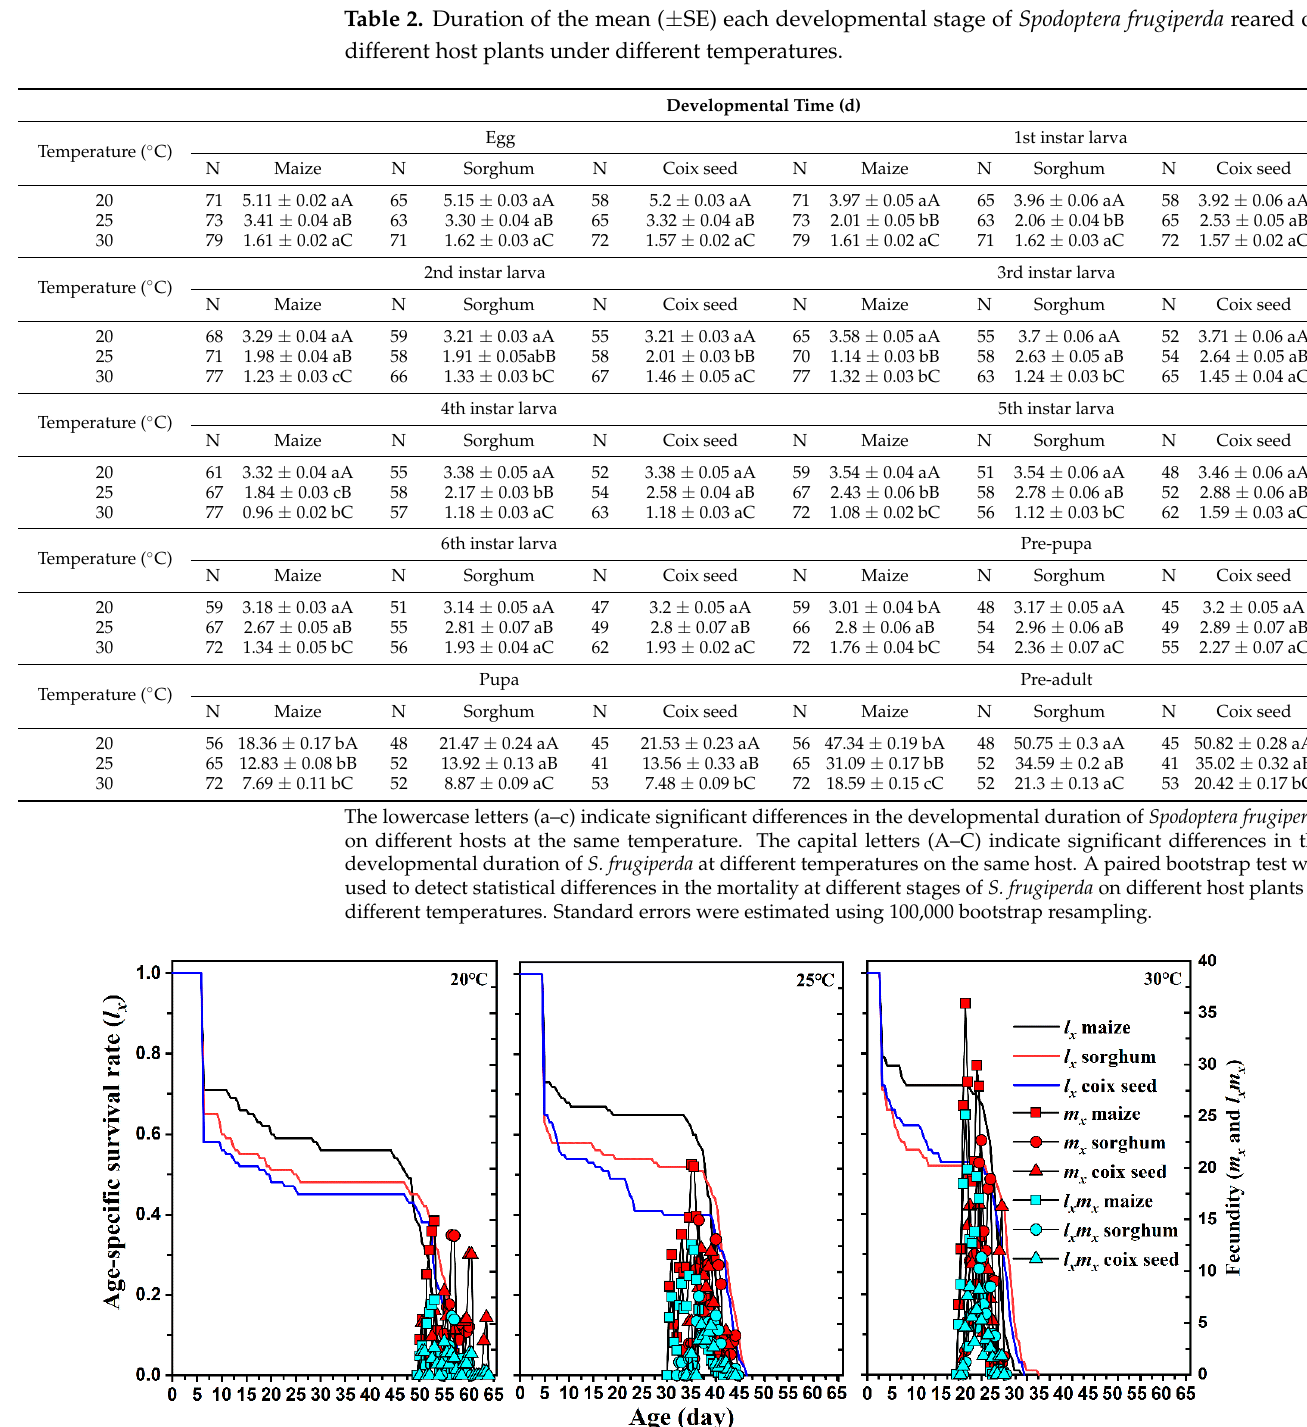
Table 2. Duration of the mean (± SE) each developmental stage of Spodoptera frugiperda reared on different host plants under different temperatures.